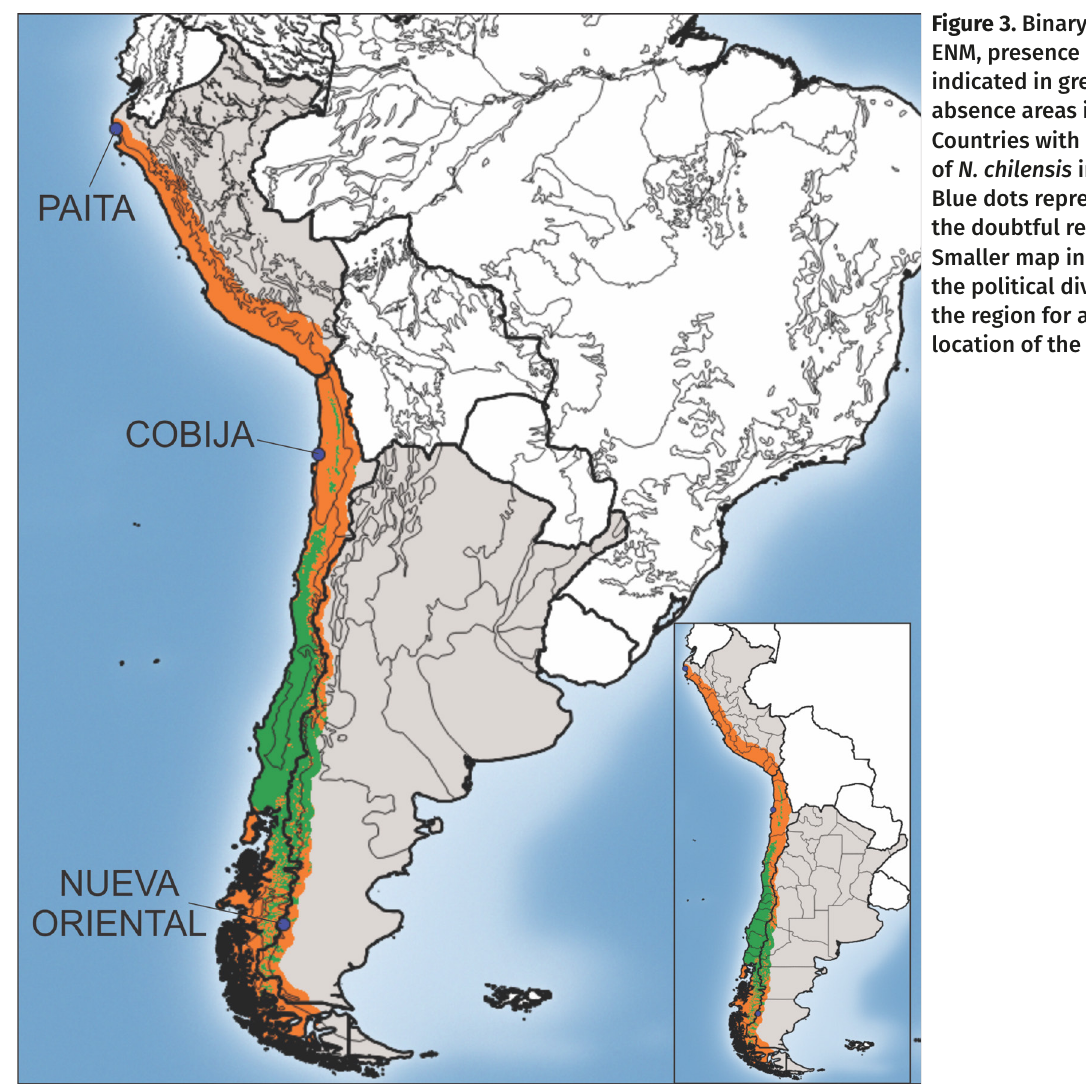
Figure 3. Binary map of ENM, presence areas are indicated in green and absence areas in orange. Countries with records of N. chilensis in gray. Blue dots represent the doubtful records. Smaller map indicates the political division of the region for an easier location of the